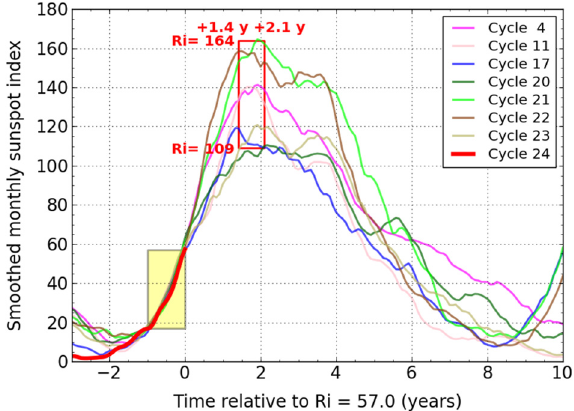
Fig. 12. Superposed-epoch plot obtained in the same way as in Fig. 11 but for a match with the cycle 24 rise (thick red curve) over the 36 months preceding July 2011. The overlaid red rectangle framing the extreme values shows a much lower range of past observed sunspot maxima and only a slightly extended range for the times of maxima. The lowest cycles seem to be characterized by a rather flat maximum, with a late peak just preceding the ultimate decline of